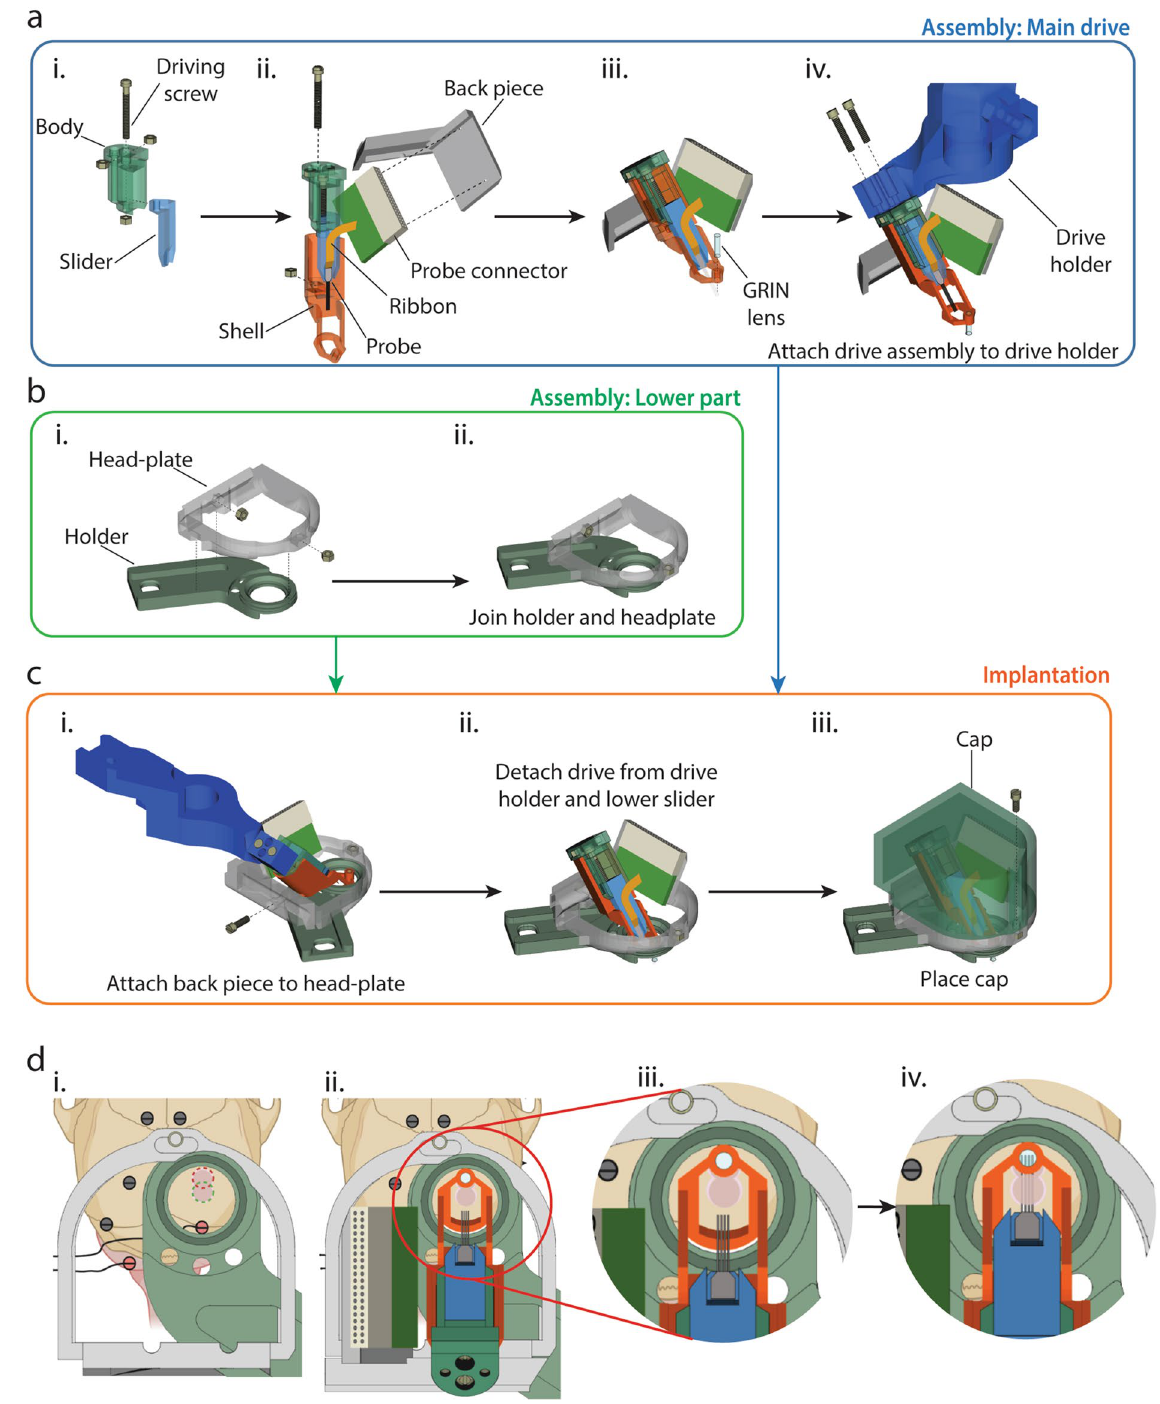
Figure 7. 3D printed scaffold for a GRIN lens and a silicon probe and its implantation on the mouse skull. ( a ) Assembly of a scaffold. i. The slider and body are held together via a screw and a nut. Two extra nuts are placed in the body to later attach the completed scaffold to the drive holder in iv. ii. Attachment of the probe tip and connector to the slider and back piece, respectively using the Metabond glue. The shell and the slider + body are held together via another set of a screw and a nut. iii. Mounting of a GRIN lens on the shell. iv. Attachment of the scaffold to a drive holder for implantation. ( b ) Assembly of lower part. i. a head-plate and head-fixation holder. ii. Fixation of the two pieces with glue. ( c ) Implantation and protection by cover. i. Positioning of the scaffold using a stereotaxic manipulator. ii, Release of the scaffold from the drive holder after implantation. iii, Protection by cover after surgery. ( d ) Diagram for the implantation of the 3D printed scaffold. i. Positioning of the head plate and craniotomy. Two overlapping circular craniotomies (Red and green). ii. Positioning of the scaffold on the skull. The GRIN lens is inserted into the anterior craniotomy. iii. Magnified view of ii. iv. Insertion of the tip of the silicon probe into the